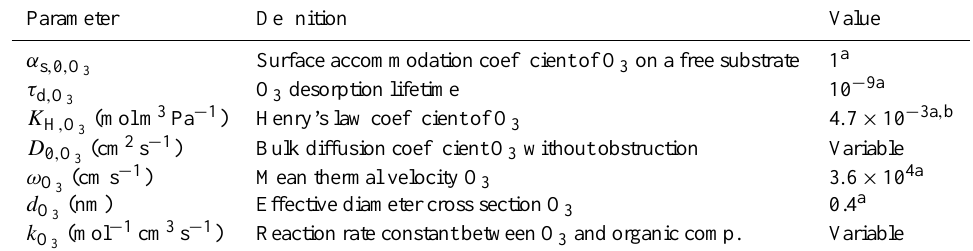
Table 1. Model parameters used in the multilayer module for O 3 uptake, diffusion and reactions in the particle phase. Parameter